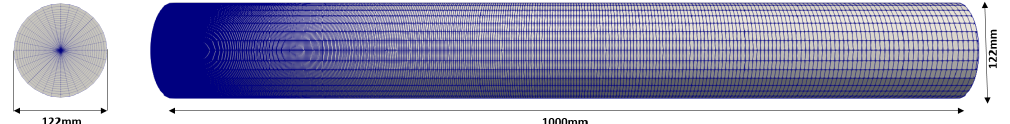
Figure 10. Dimension of the computational domain of mesh 2 consisting of the chamber alone.